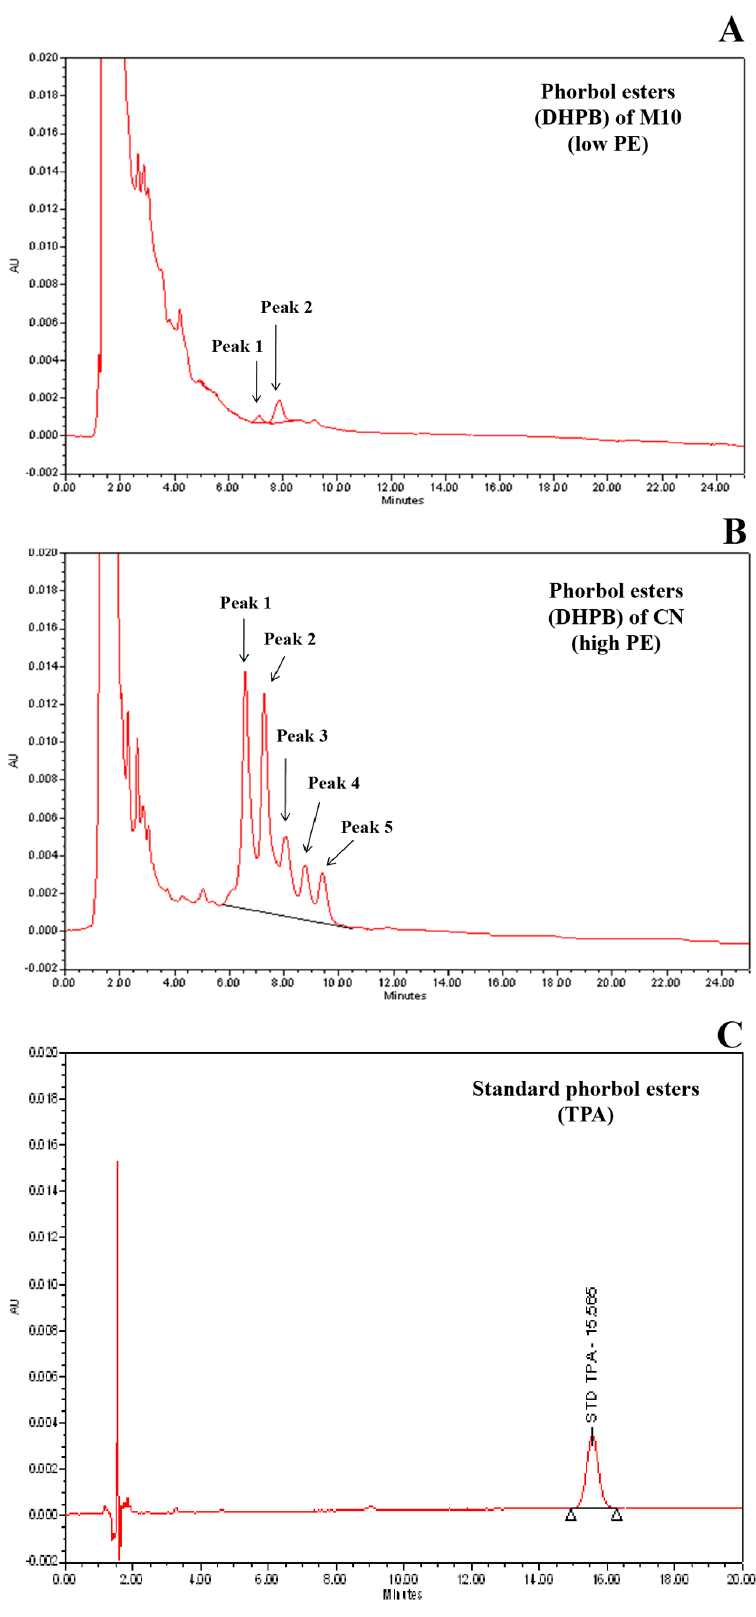
Figure 1. High Pressure Liquid Chromatography (HPLC) chromatogram of phorbol esters in seed of M10 (non-toxic Jatropha) ( A ) and Chai Nat (toxic Jatropha) ( B ) and of phorbol 12-myristate 13-acetate (TPA) ( C ). DHPB: 12-deoxy-16-hydroxyphorbol; PE: phorbol esters; CN: Chai Nat.